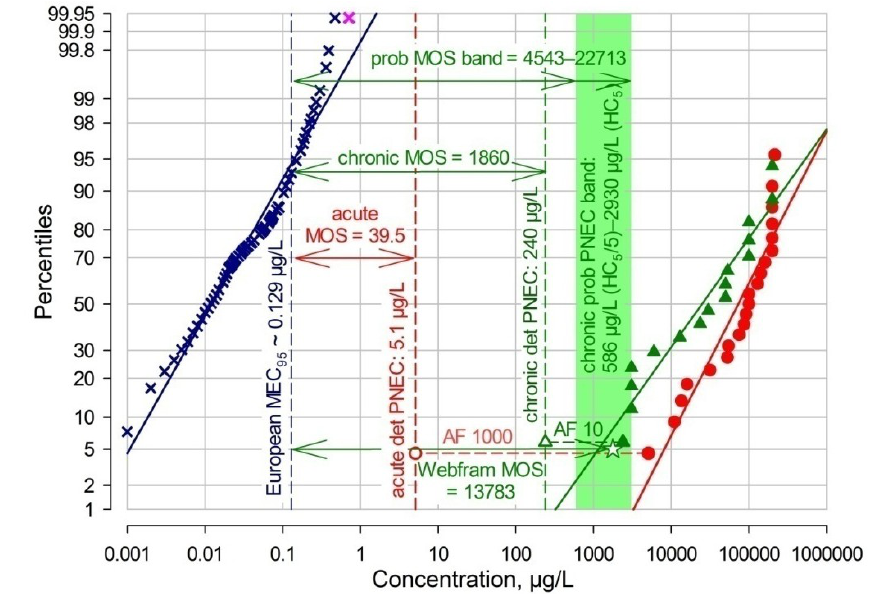
Figure 5. TMP risk graph for European surface